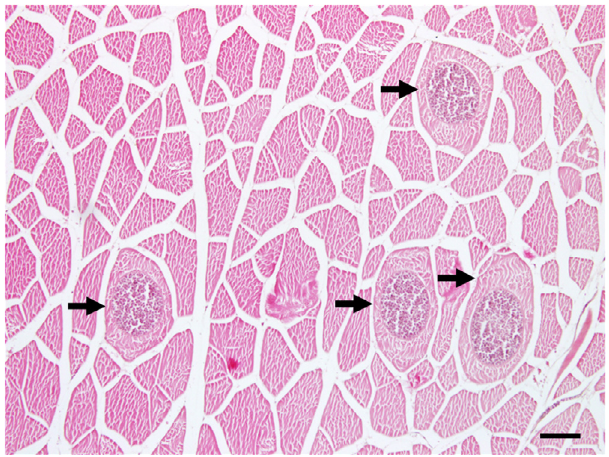
Figure 2. Phase-contrast micrograph of Kudoa septempunctata spores. Scale bar = 5 l